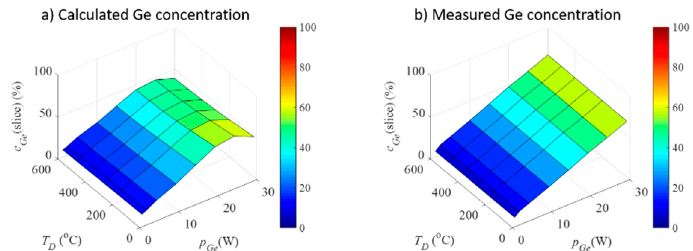
Figure 6. ( a ) Measured and ( b ) calculated from the GISAXS ‐ fit, Ge concentration in dependence on the deposition parameters.